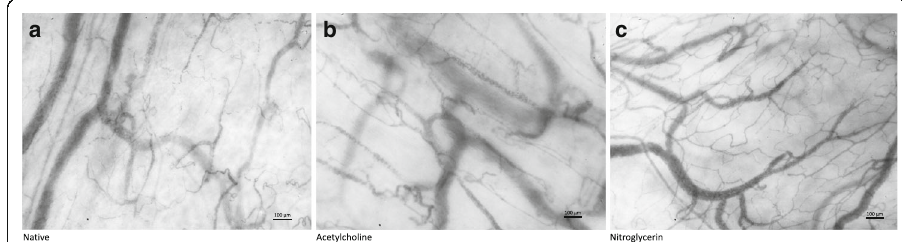
Fig. 3 Representative still images and space-time diagrams of the venules depicting the native sublingual microcirculation ( a ) as well as after the topical sublingual application of acetylcholine ( b ) and nitroglycerin ( c ). Stimulation with nitroglycerin leads to an increase of total vessel density through recruitment of capillaries and an increase in flow velocity in the capillaries and